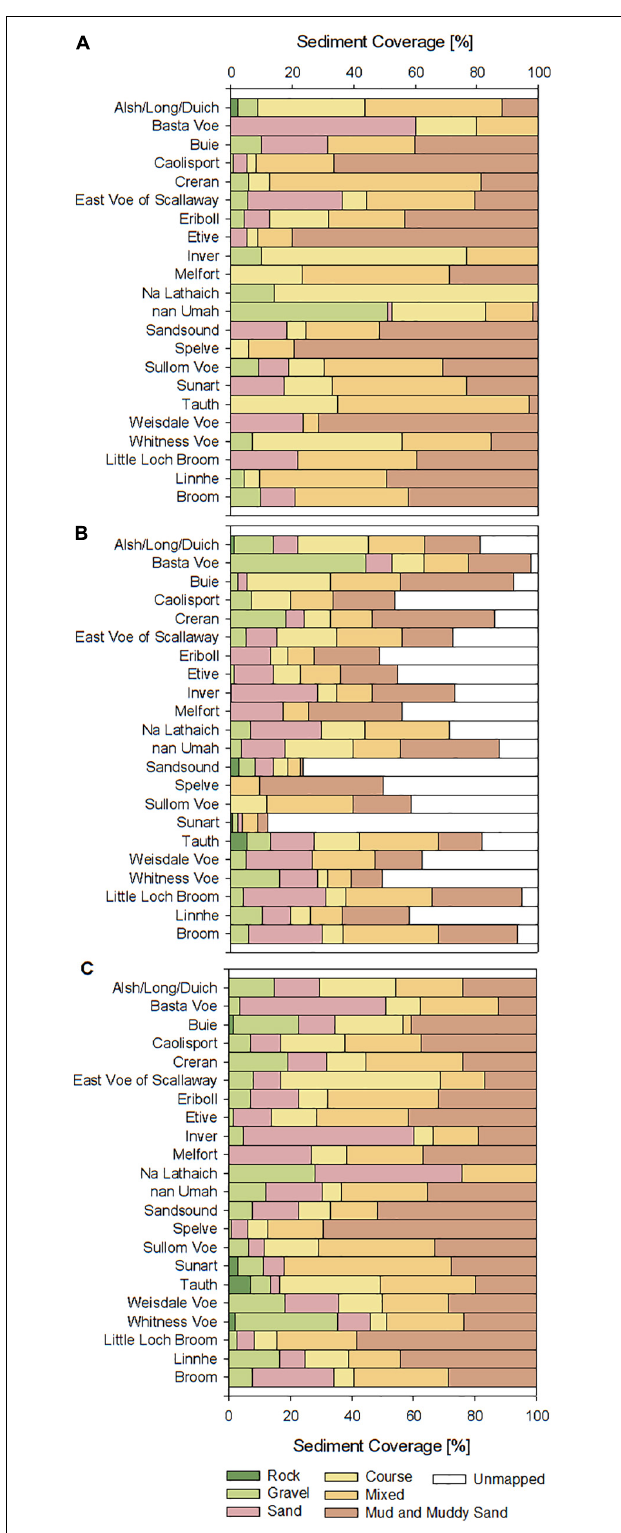
FIGURE 5 | Visualization of the difference between the three-tiered mapping approach across the Scottish fjords with all data types. (A) Tier 1, point observations, (B) Tier 2, backscatter, and (C) Tier 3